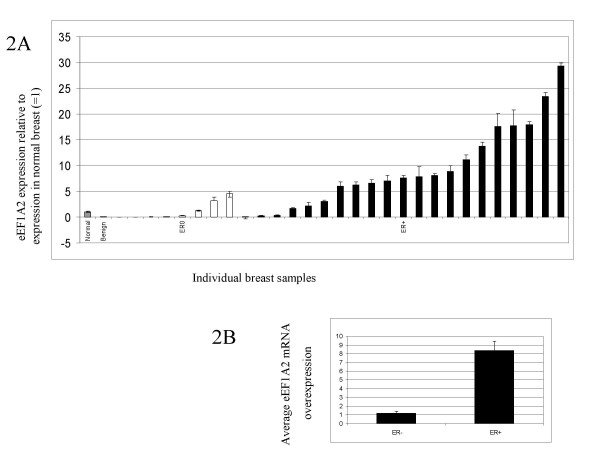
(A) Real-time RT-PCR analysis of RNA from breast tumours. Each block on the × axis represents a different tumour. The amount of eEF1A2 message is shown normalised to GAPDH and expressed relative to the level of expression in the normal breast RNA samples (=1). ER-negative tumours are shown in white, ER-positive tumours are shown in black. The difference in mean expression between ER-positive and ER-negative samples is 7.2 units (p = 0.0087), 95% Confidence Interval 2.0 to 12.4 units. (B) Average standardised RNA levels in ER-negative and ER-positive breast tumours. This difference is significant (P = 0.0087, t-test).